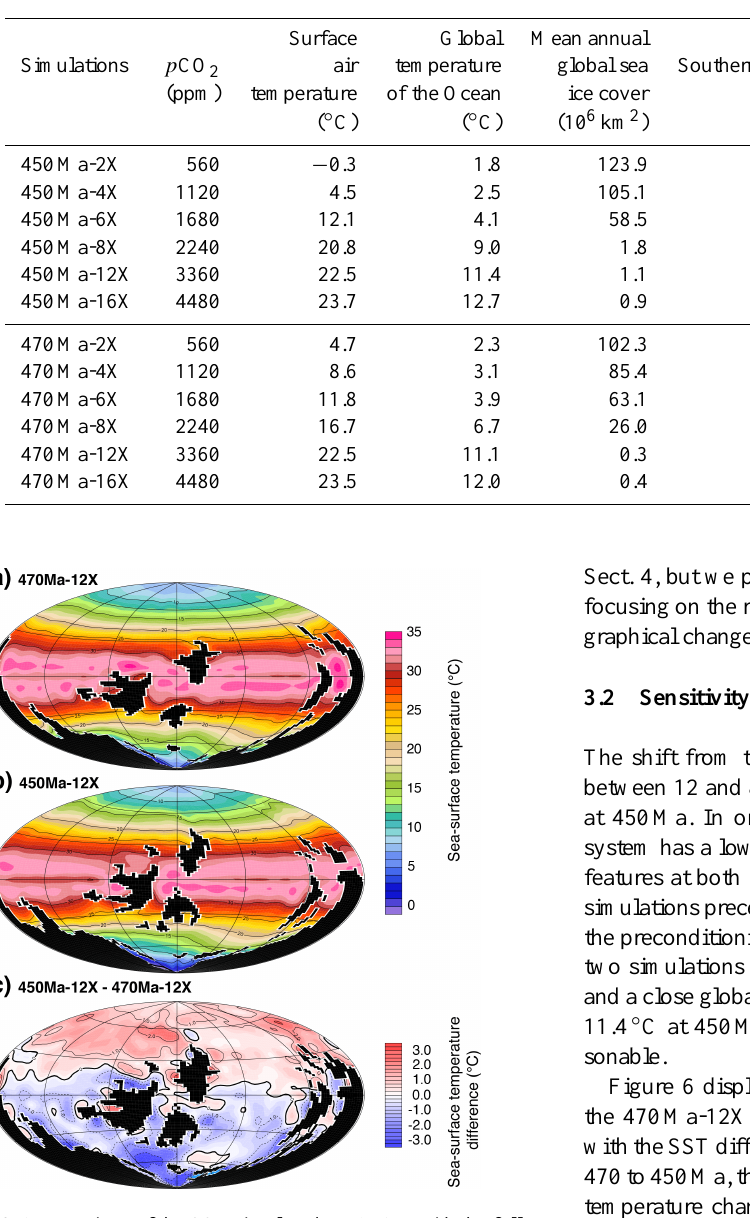
Figure 6. Comparison of the SST simulated at 12PAL with the fully coupled version of FOAM for the two continental configurations used in this study. The black mask stands for continental masses. Note that, for the plot presented in (c) , the mask actually represents all the grid points where the SST difference could not be calculated, cumulating each point that is a continent either in the 450 or in the 470Ma